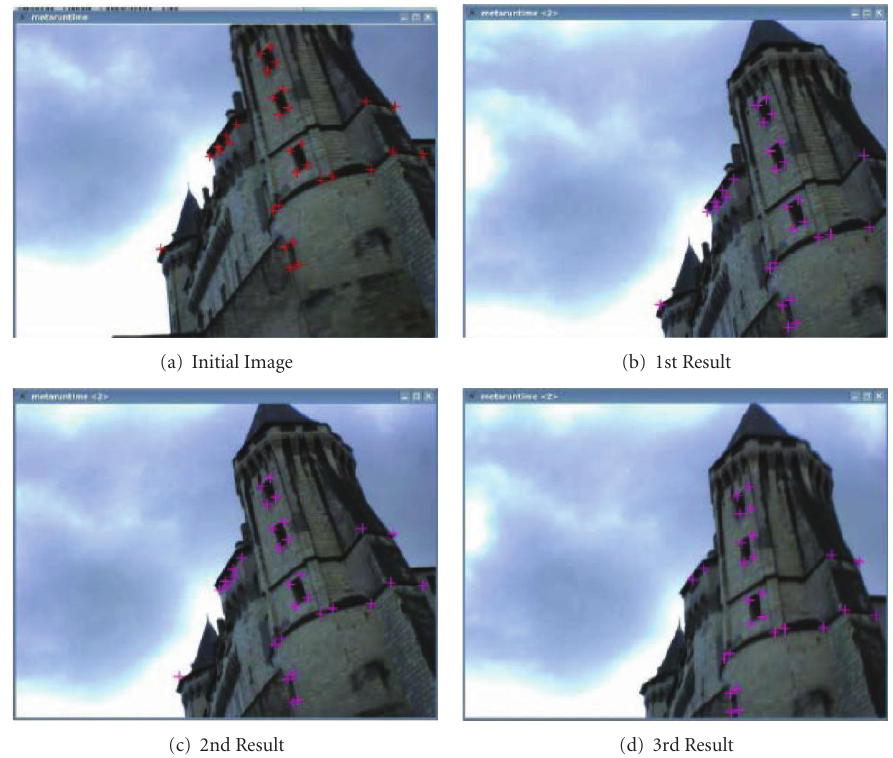
Figure 10: Matching results for autometed initialization approach-Non coplanr